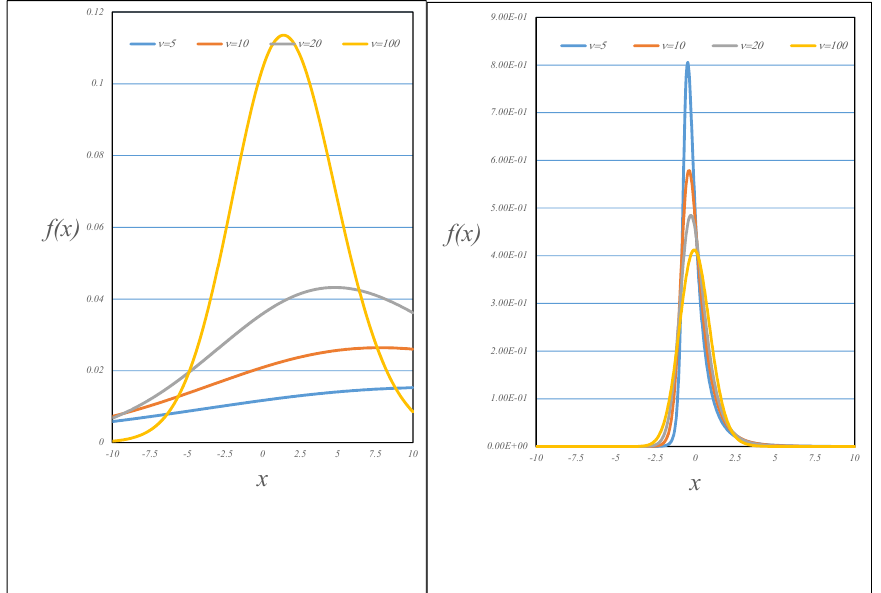
The figures show sketches of the extended [left hand panel] and standardised extended [right hand panel] skew-Student density functions for  = -30,  = 5 and  = 5, 10, 20 and 100. The X-scales are the same in each panel. Figure 9. Extended and standardized skew-Student density functions, τ = − 35, − 10.